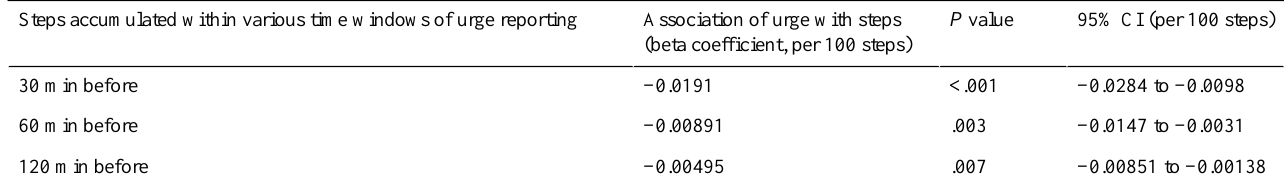
Table 2. Feasible generalized least squares regression results of smoking urge versus steps over various time windows before urge reports.